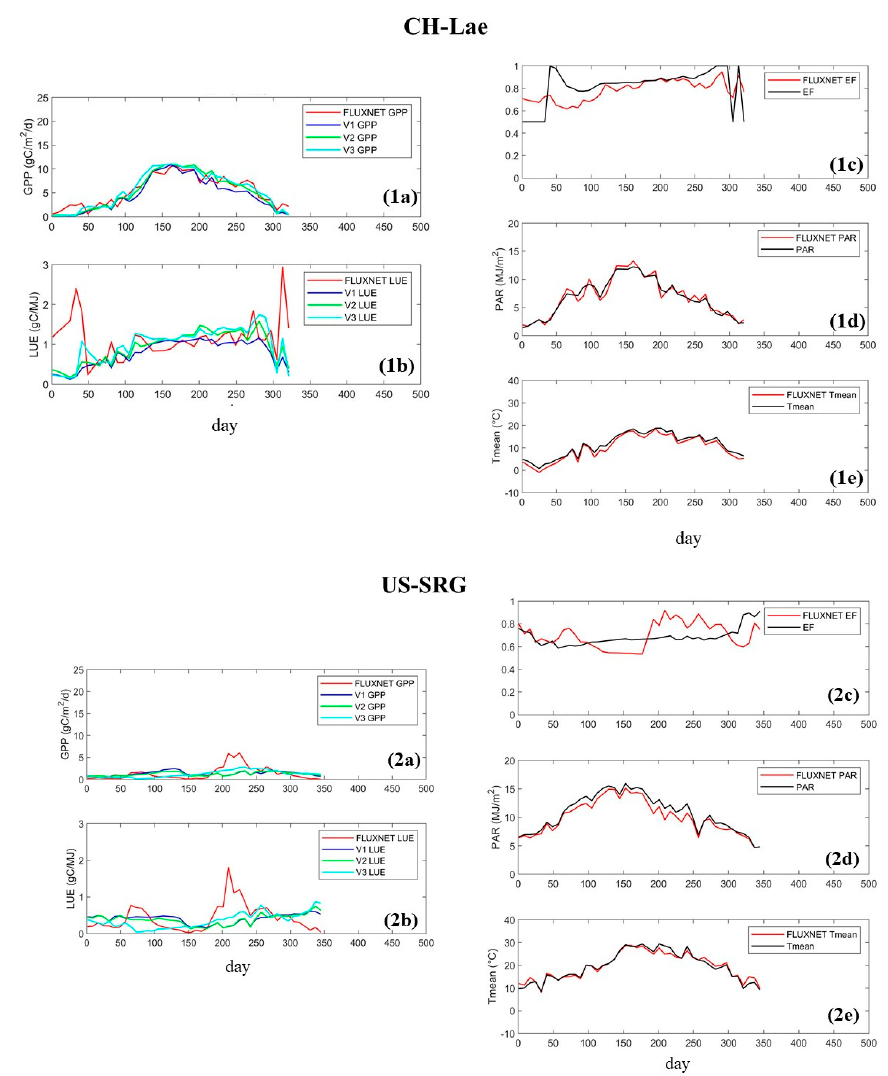
Figure 12. The curves of GPP ( a ), LUE ( b ), EF ( c ), PAR ( d ), Tmean ( e ) in CH-Lae (1) and US-SRG (2).